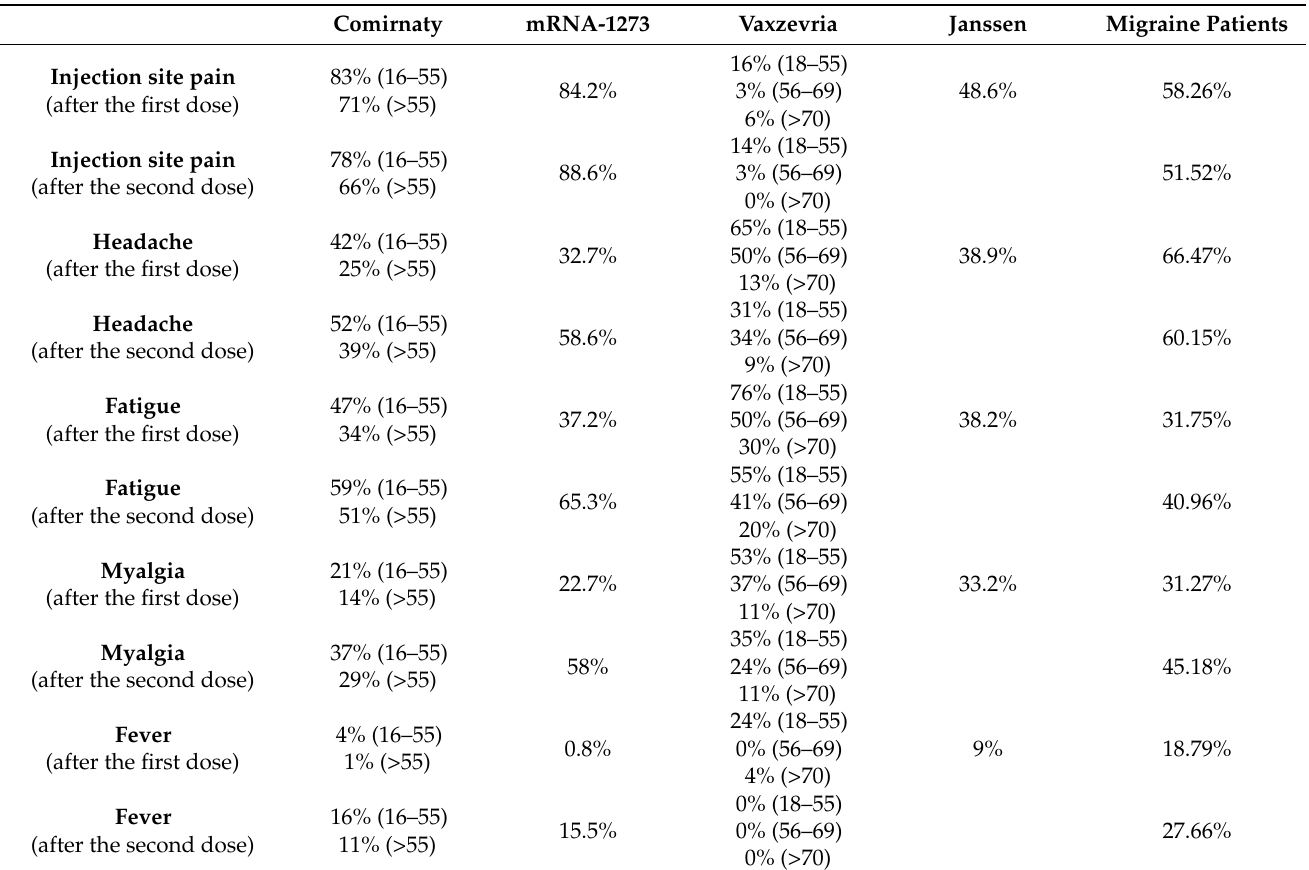
Table 3. Most common local and systemic adverse reactions of COVID-19 vaccines in general population from RCTs, and in migraine patients, from the online questionnaire. Comirnaty mRNA-1273 Vaxzevria Janssen Migraine